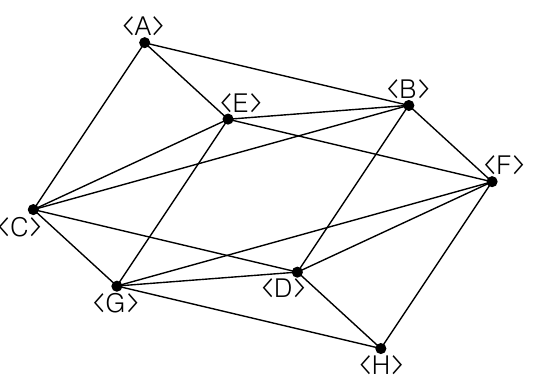
Figure 8 . Sp( N ) = U( N ), N = 4 m (cid:0) 1. Vertices, line segments and triangular faces correspond to vacua, walls and three-pronged